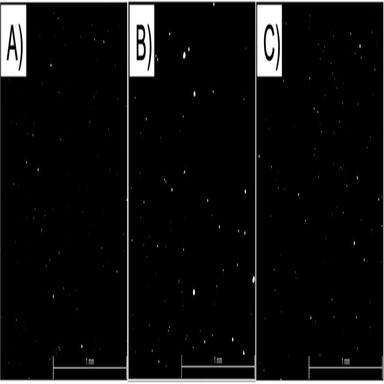
Porosity area in A) 0◦, B) 45◦ and C) 90◦ obtained by Leica DM6 M and post processed by ImageJ.